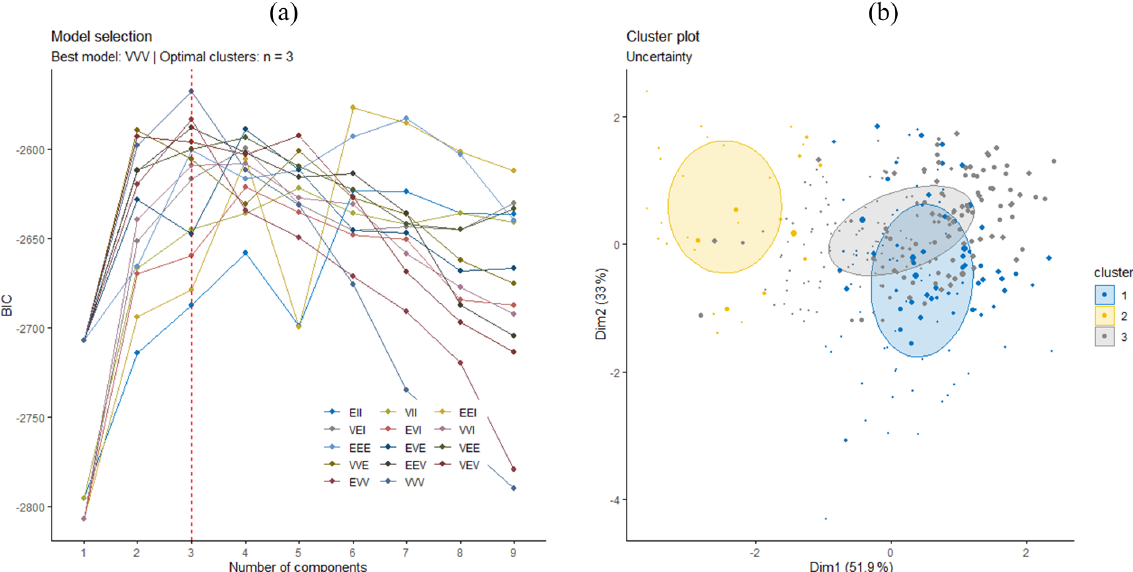
Figure B1. (a) Optimal solution (three clusters) according to the ellipsoidal volume, shape and orientation properties and (b) uncertainty cluster assignment of each weather day. There are 14 available models for more than 2 groups represented by triplets EII, VII, EEI, VEI, EVI, VVI, EEE, EVE, VEE, EEV, VEV, EVV and VVV. The first letter in a triplet refers to the cluster size (volume), the second to the shape and the third to the orientation of the multivariate distribution, with E standing for “equal”, V for “variable” and I for “coordinate axes”. DIM1 and DIM2 are the first two principal components used to reduce data dimensionality. For details, please see Scrucca et al.